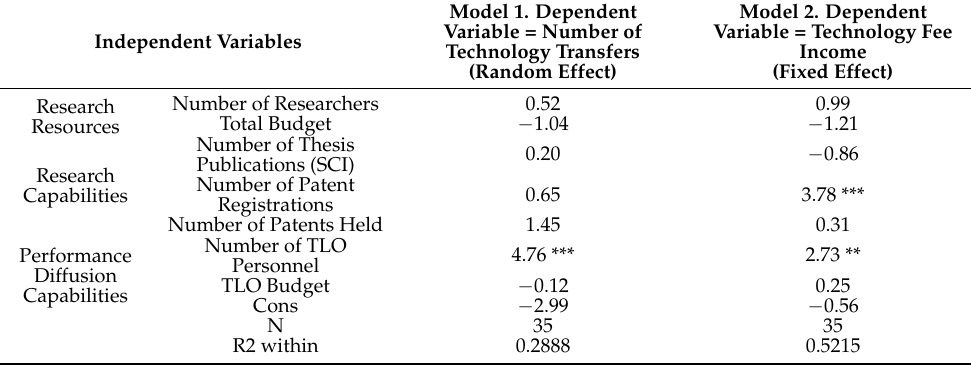
Table 8. Analysis results for industrialization